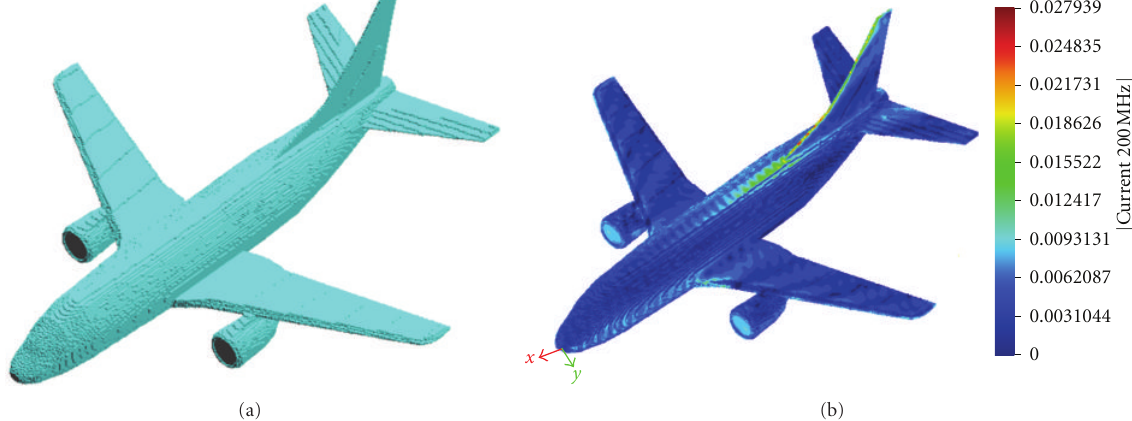
Figure 7: (a) Cartesian Mesh of the airplane and (b) smooth contour fill of the amplitude of surface inductive current on the airplane surface.